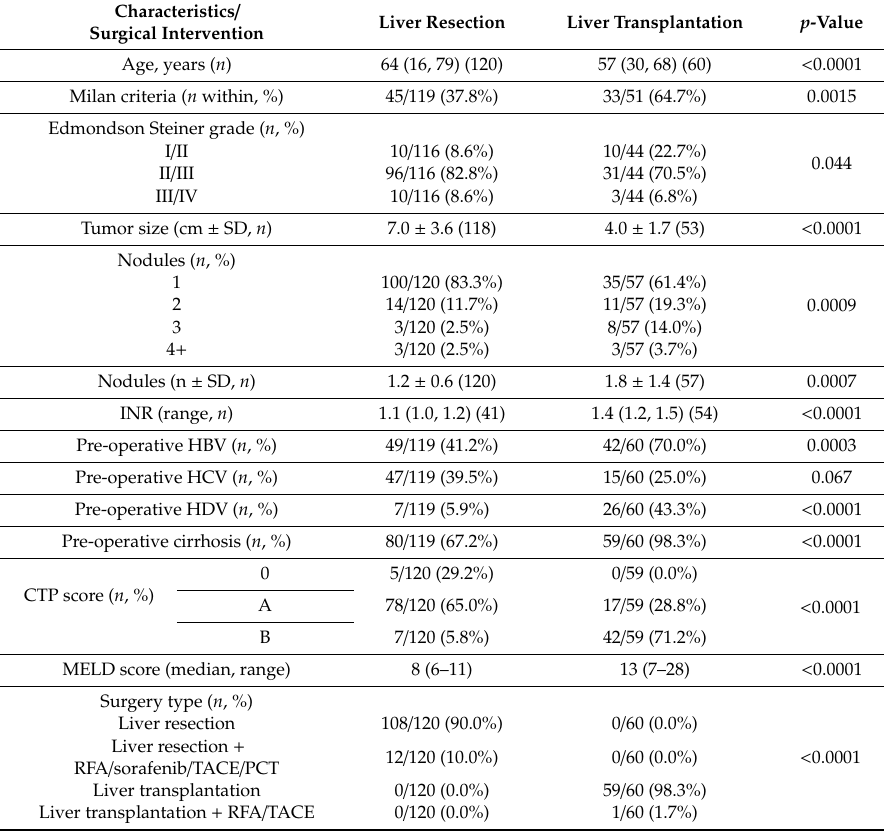
Table 1. Patient characteristics. Study enrolled 180 consecutive and eligible hepatocellular carcinoma patients. The p values are from the Wilcoxon / Fisher’s exact